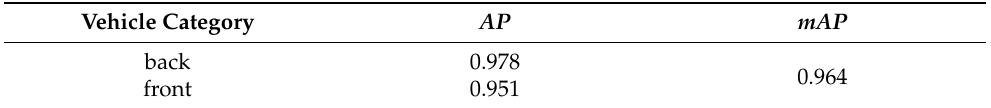
Table 2. Detection performance of